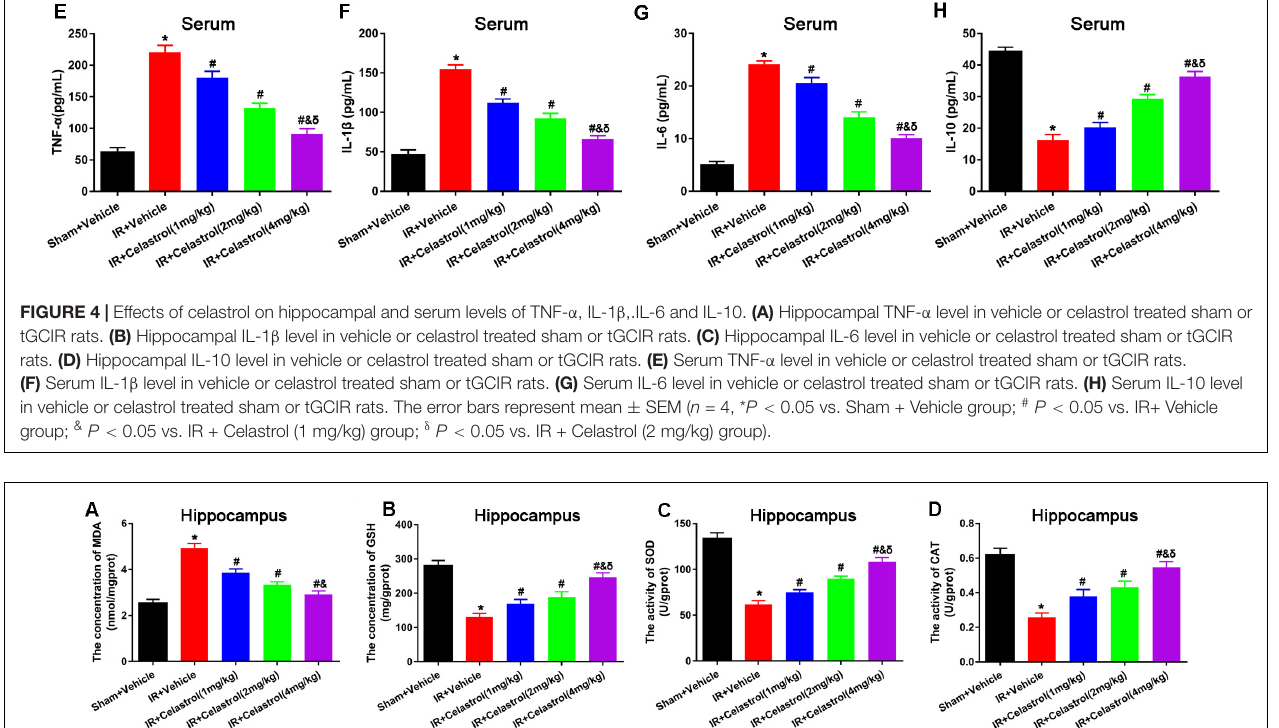
FIGURE 5 | Celastrol alleviates tGCI/R induced oxidative stress in the hippocampus. (A) The hippocampal MDA level in vehicle or celastrol treated sham or tGCIR rats. (B) The hippocampal GSH level in vehicle or celastrol treated sham or tGCIR rats. (C) The hippocampal SOD activity in vehicle or celastrol treated sham or tGCIR rats. (D) The hippocampal CAT activity in vehicle or celastrol treated sham or tGCIR rats. The error bars represent mean ± SEM ( n = 4, * P < 0.05 vs. Sham + Vehicle group; # P < 0.05 vs. IR+ Vehicle group; & P < 0.05 vs. IR + Celastrol (1 mg/kg) group; δ P < 0.05 vs. IR + Celastrol (2 mg/kg) group).